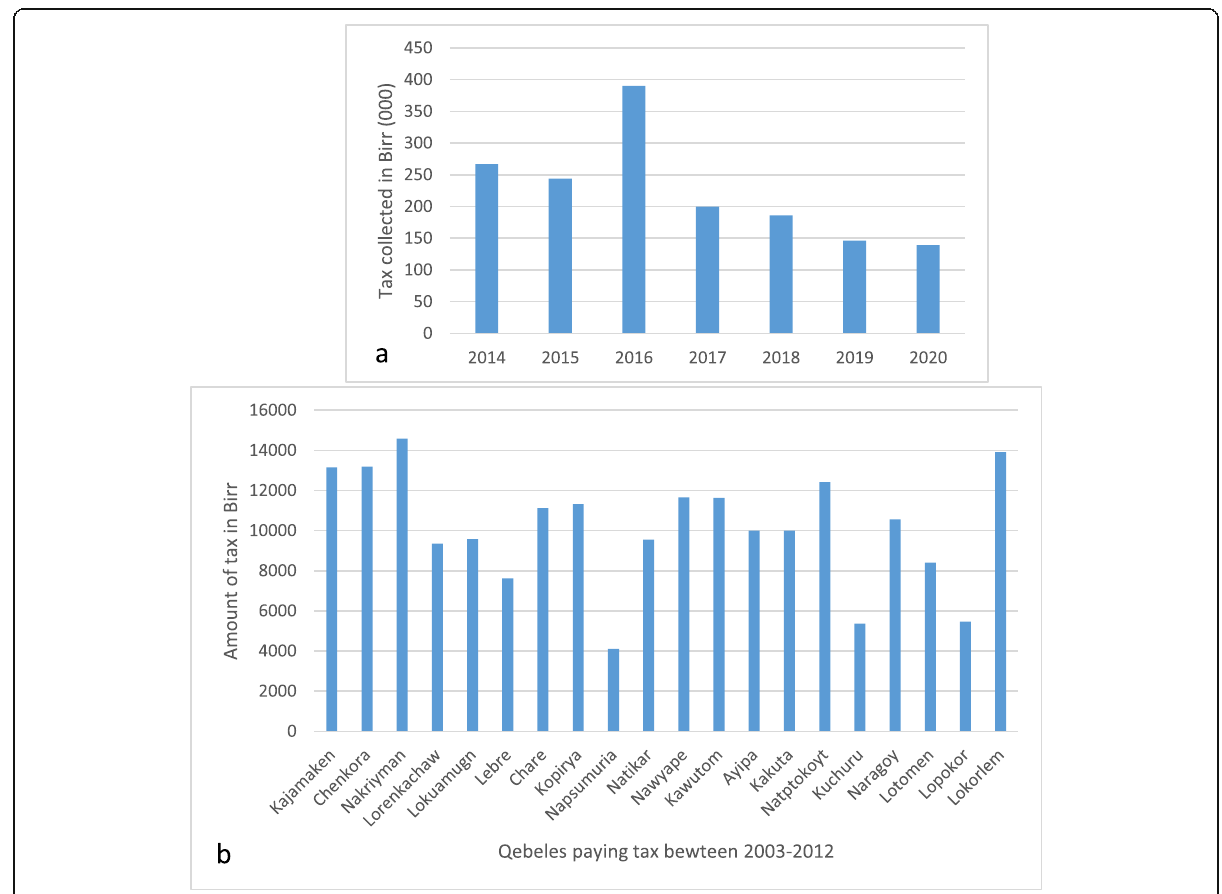
Fig. 6 a Employment taxes from the private agricultural investment. b Taxes from local sources (source: Nyangatom revenue